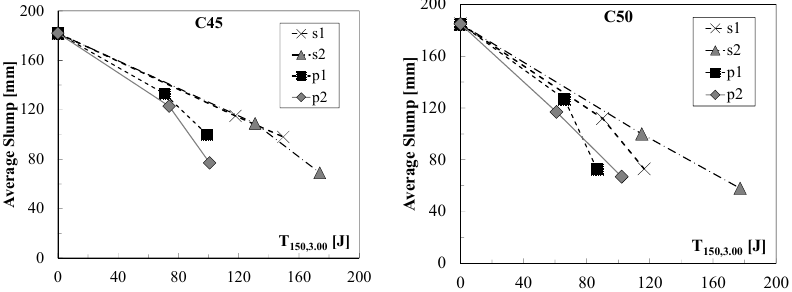
Figure 8. Slump value vs. flexural toughness (T 150,3.00 ) for concrete C45 ( left ) and C50 ( right ) in case of plain concrete (PC) and fiber reinforced concretes ( V f = 0.5% and V f = 1%).